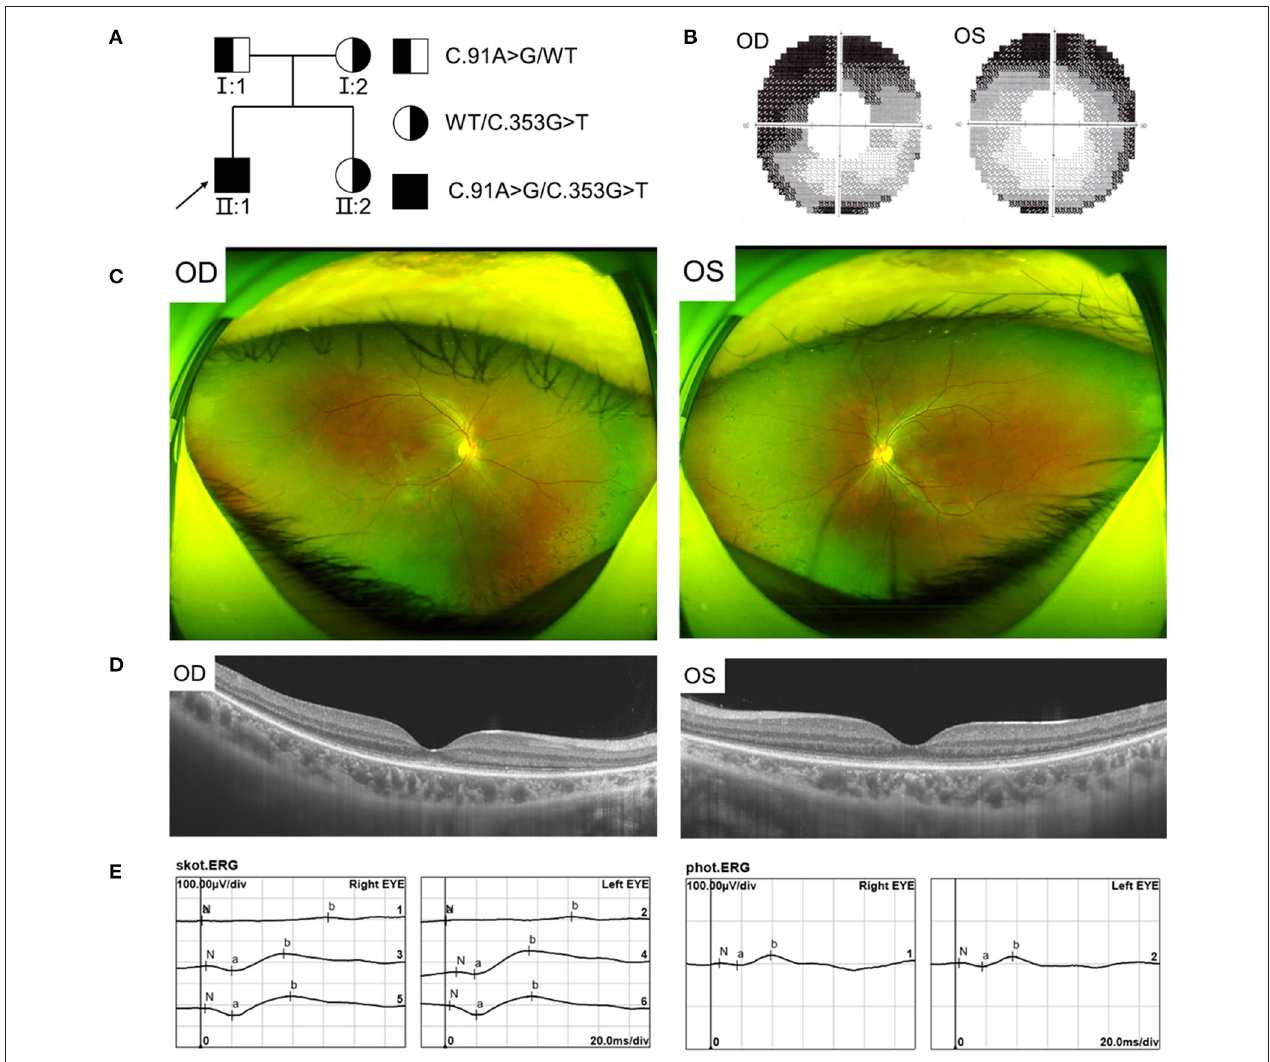
FIGURE 1 | Pedigree and Clinical features of the proband with RCD. (A) Pedigree of the family with autosomal recessive RCD. (B) Visual field showed tunnel vision. (C) Fundus photographs showed peripheral bone spicule pigmentation. (D) SS-OCT showed atrophy of the retinal outer layers of the binocular macular area. (E) ERG showed severe reduced rod responses and to less extent cone